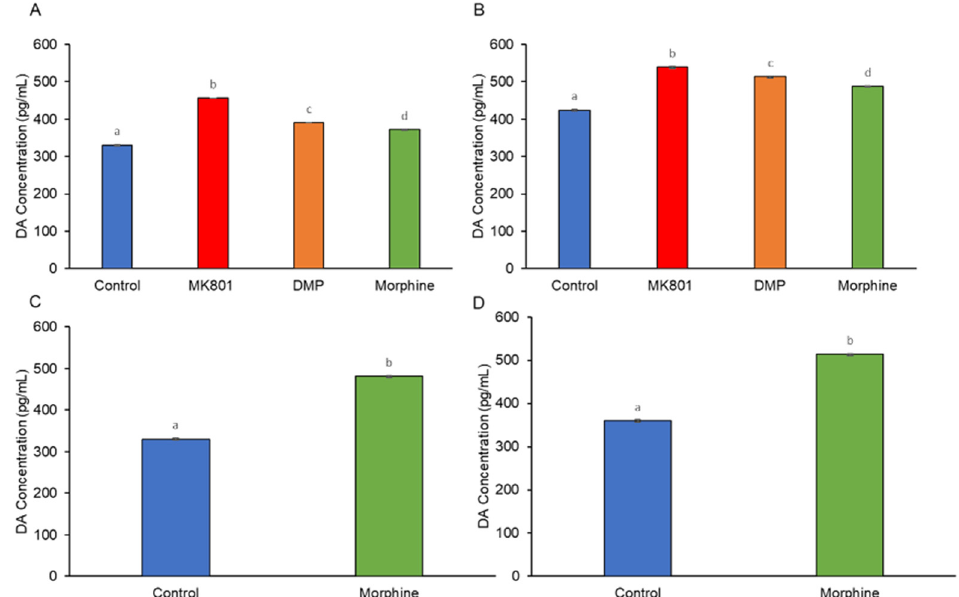
Figure 7. Effects of ( A ) short-term (F (3, 32) = 20.09, p = 0.00) and ( B ) long-term (F (3, 32) = 22.17, p = 0.00) exposure to MK801, DMP, and morphine, and after withdrawal of ( C ) short-term (t (16) = 206.7, p = 0.00) and ( D ) long-term (t (16) = 56.83, p = 0.00) morphine treatment on the DA concentration (pg/mL) of the zebrafish larvae brain. Data expressed as mean ± SEM, n = 50 of 3 independent experiments. Different alphabets indicate statistically significant values, p < 0.05. Drug abbreviation: DMP, domperidone. Other abbreviation: DA, dopamine.